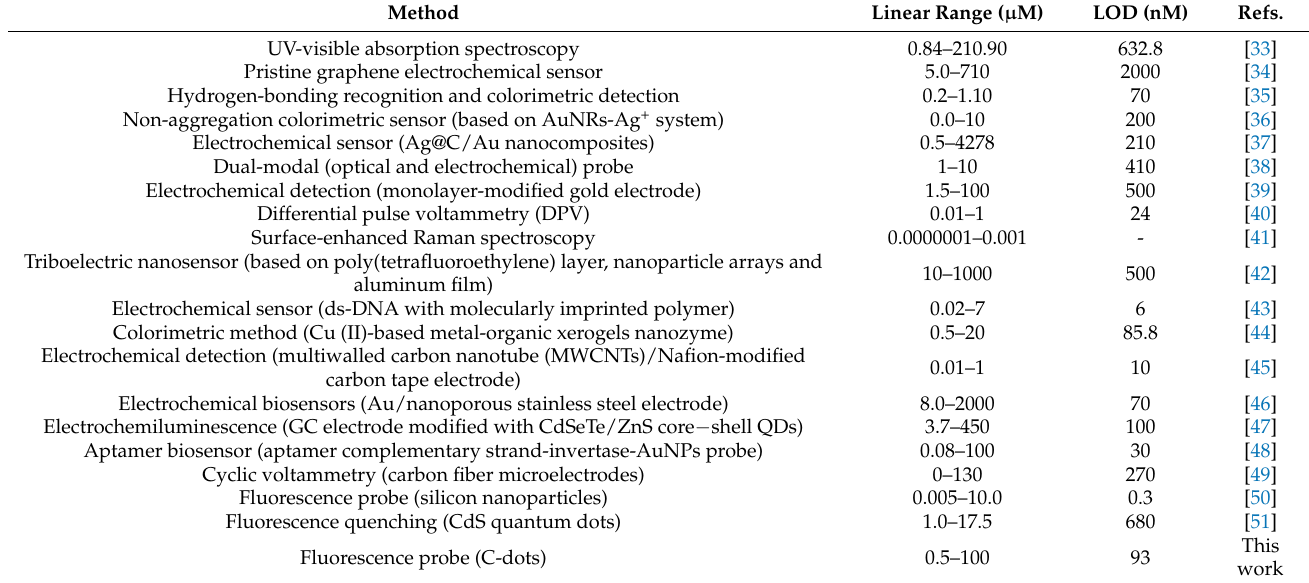
Table 3. Comparison of different methods for the determination of